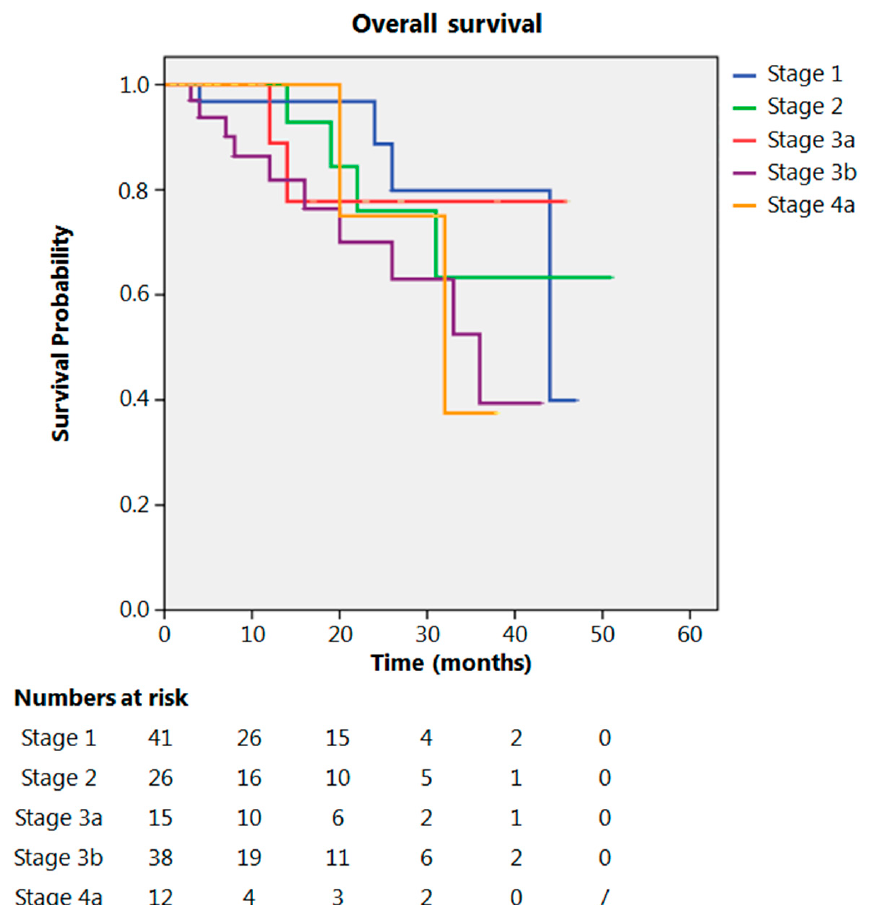
Even after clustering the pathological stages after the CROSS regimen, no differ- ences emerged in terms of OS ( p = 0.315) (Figure 2). Patients with yp Stage I and II had a significantly longer time to recurrence in comparison to all other stages ( p = 0.013) (Figure 3). No differences in terms of OS emerged from the comparison of ypN0 patients with ypN+ patients, ( p = 0.117) (Figure 4). The 50-month DFS for these two groups of patients was 11% and 8%, respectively, for ypN0 and ypN+, and time to relapse was significantly longer for the ypN0 group ( p = 0.005) (Figure 5).